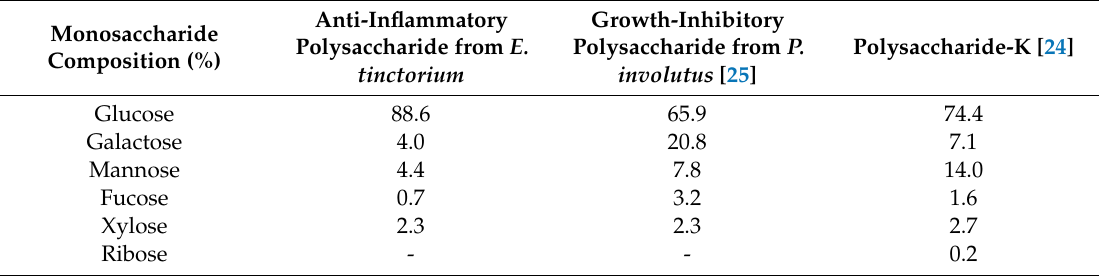
Table 1. Monosaccharide composition of purified anti-inflammatory polysaccharide from E. tinctorium (AIPetinc).